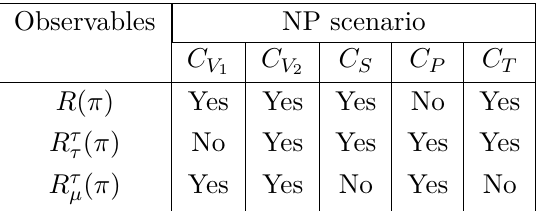
provided predictions of these observables for a few benchmark values of the new WCs in table 11 in the appendix. Some observations from table 3 and figure